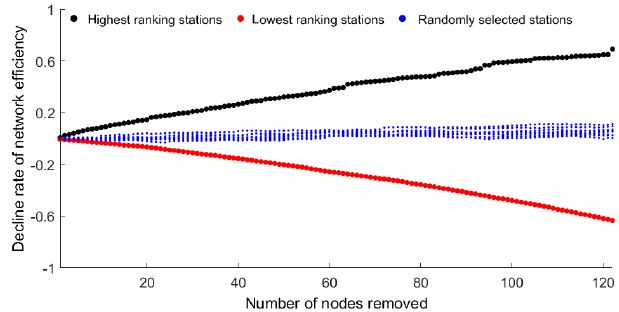
Figure 6. Decline rate of network efficiency as a function of the number of stations removed from the network. In case I, up to 10% of the highest ranking stations are removed (black); in case II, up to 10% of the lowest ranking stations are removed (red); and in case III, up to 10% of randomly drawn stations are removed (10 trials;